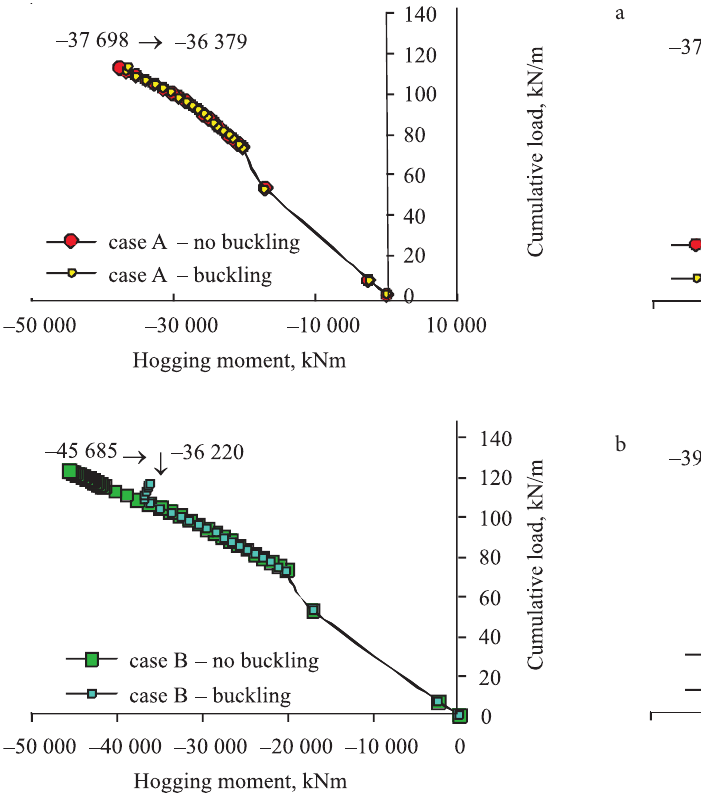
Fig. 13. (θ – M) – bean H3 case A (a) and case B (b)